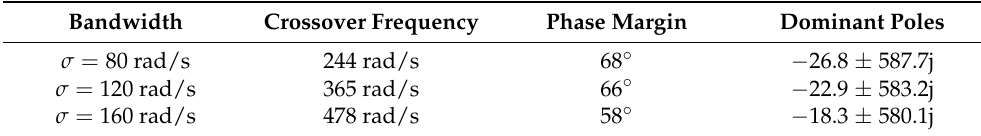
Figure 9. Bode diagram: ( a ) Bode diagram of G o ( s ) under different σ . ( b ) Closed-loop pole distribution of G c ( s ) under different σ . Table 2. Key metrics of the enhanced LESO-based QPLL under different σ .